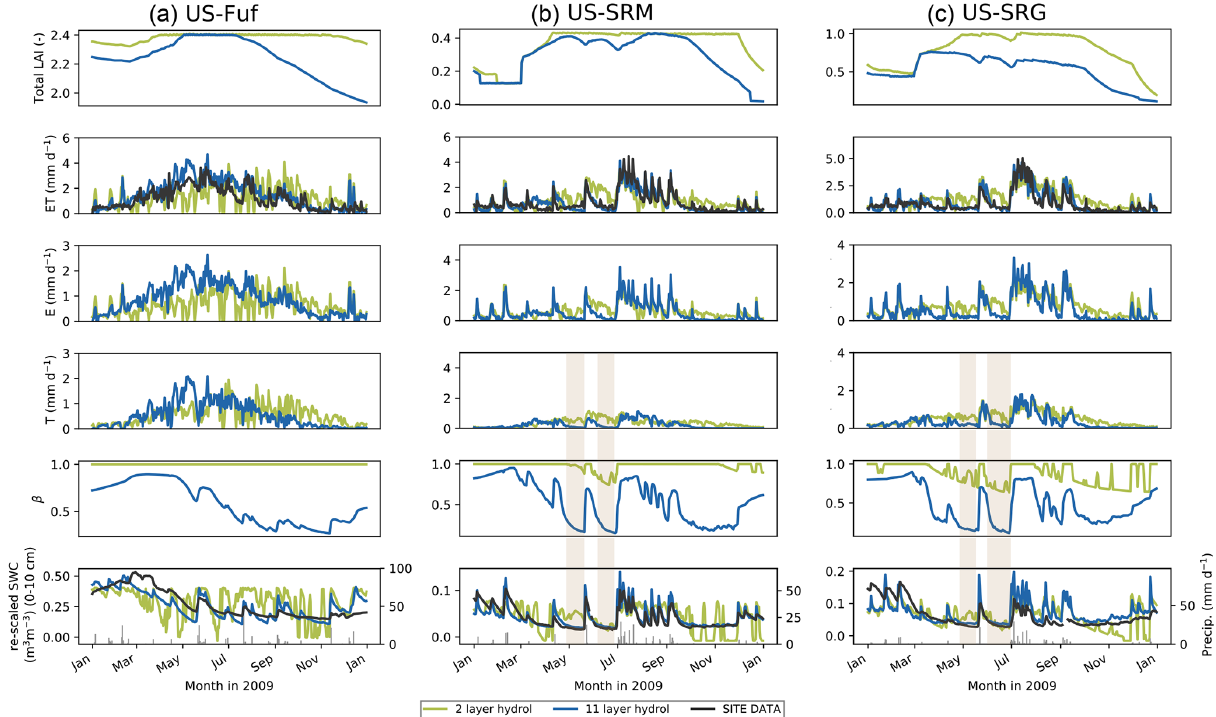
Figure 2. Comparison of daily time series (for 2009) of upper-layer soil moisture, surface water fluxes, and related variables between the 2LAY (green curve) and 11LAY (blue curve) simulations. Changes between the two versions are shown for three sites representing the main vegetation types: left column: high-elevation tree-dominated site (US-Fuf); middle column: low-elevation mesquite shrub-dominated site (US-SRM); right column: low-elevation C 4 grass site (US-SRG). At each site, top panel: LAI; 2nd panel: ET compared to observations (black curve); 3rd panel: bare soil evaporation; 4th panel: transpiration; 5th panel: empirical water limitation function ( β ) that scales photosynthesis and stomatal conductance; bottom panel: model soil moisture (re-scaled via linear CDF matching) expressed as volumetric soil water content (SWC) in the uppermost 10cm of the soil compared to observations (black curve). Precipitation is shown in the grey lines in the bottom panel for each site. (Note: full time series across all years are shown for all site in Fig. S2a–f.) Light brown shaded zones show periods of maximum plant water limitation ( β ) at Santa Rita and consequent troughs in T and